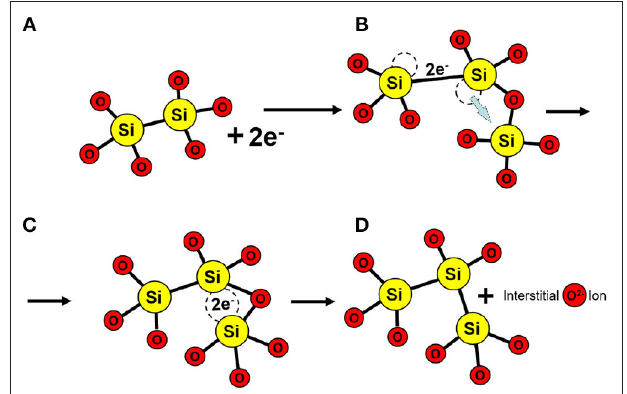
FIGURE 9 | Schematic illustrating the correlated defect creation mechanism. (A) O Vacancies can trap up to two electrons; and (B) distort the amorphous structure. (C) In rare cases, the HOMO of the charged vacancy points toward a neighboring Si atom and forms a bond to (D) create a new vacancy and interstitial O.